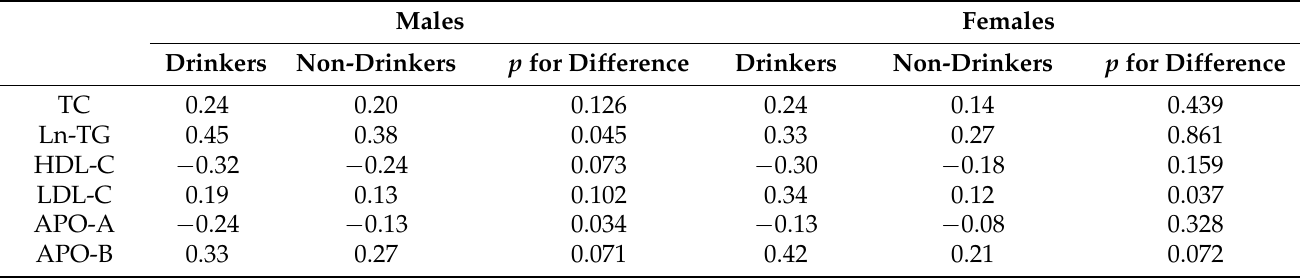
Table 3. The standardized regression coefficients of body mass index for lipids by different drinking groups in males and